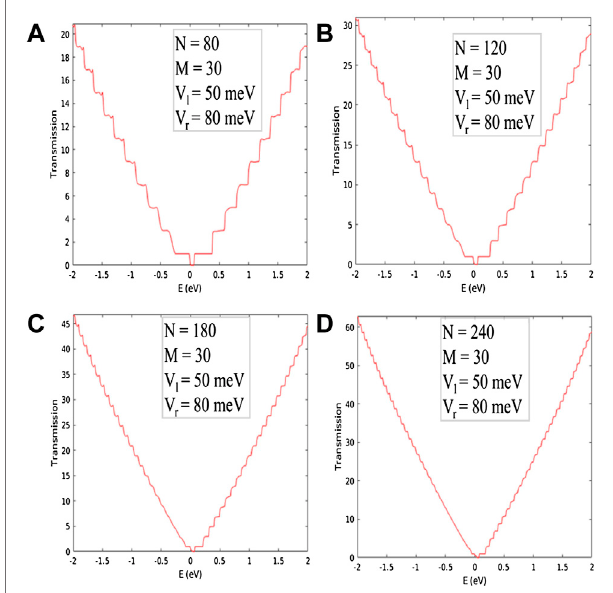
FIGURE 8 | Transmission for symmetric potential well with (A) N = 80, (B) N = 120, (C) N = 180, and (D) N = 240.